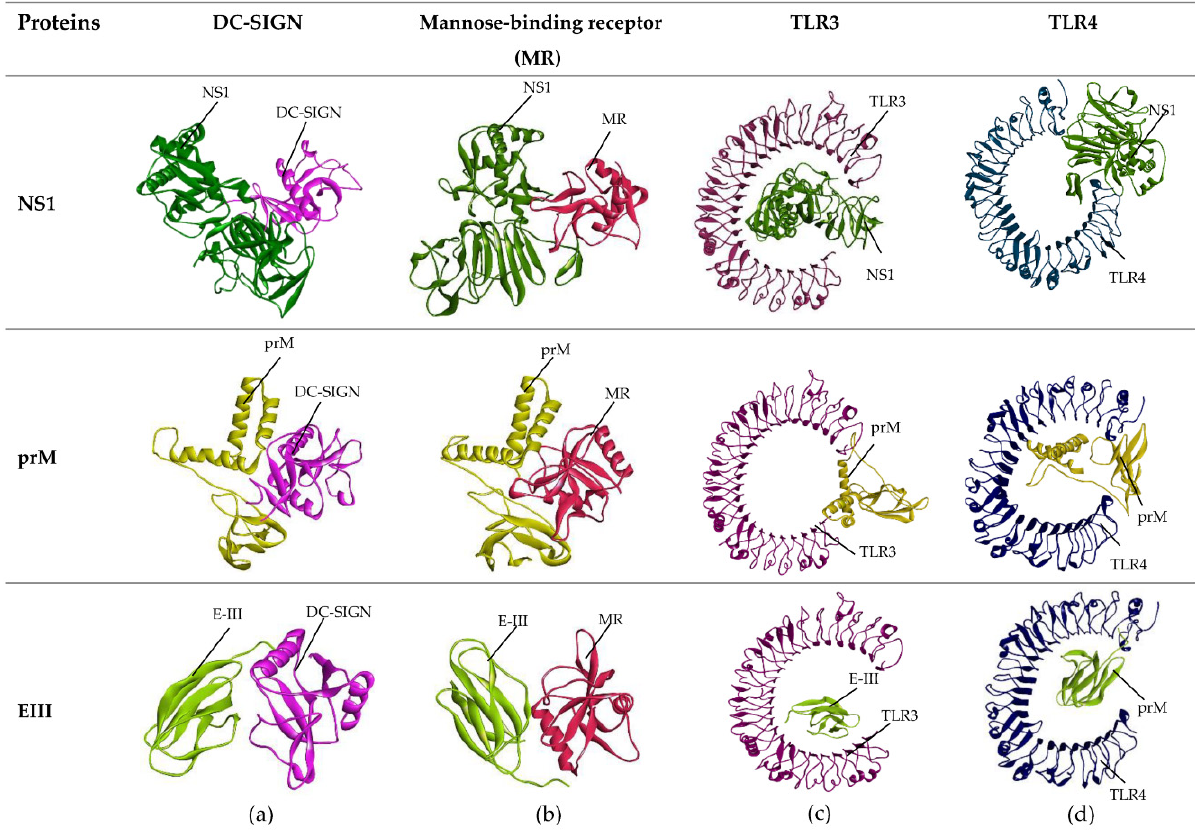
Figure 6. Docking complex of NS1, prM, and EIII proteins and immune receptors. ( a ) DC-SIGN immune receptor complex with candidate vaccine proteins; ( b ) mannose-binding receptor (MR) complex with candidate vaccine proteins; ( c ) TLR3 immune receptor complex with candidate vaccine proteins; ( d ) TLR4 immune receptor complex with candidate vaccine